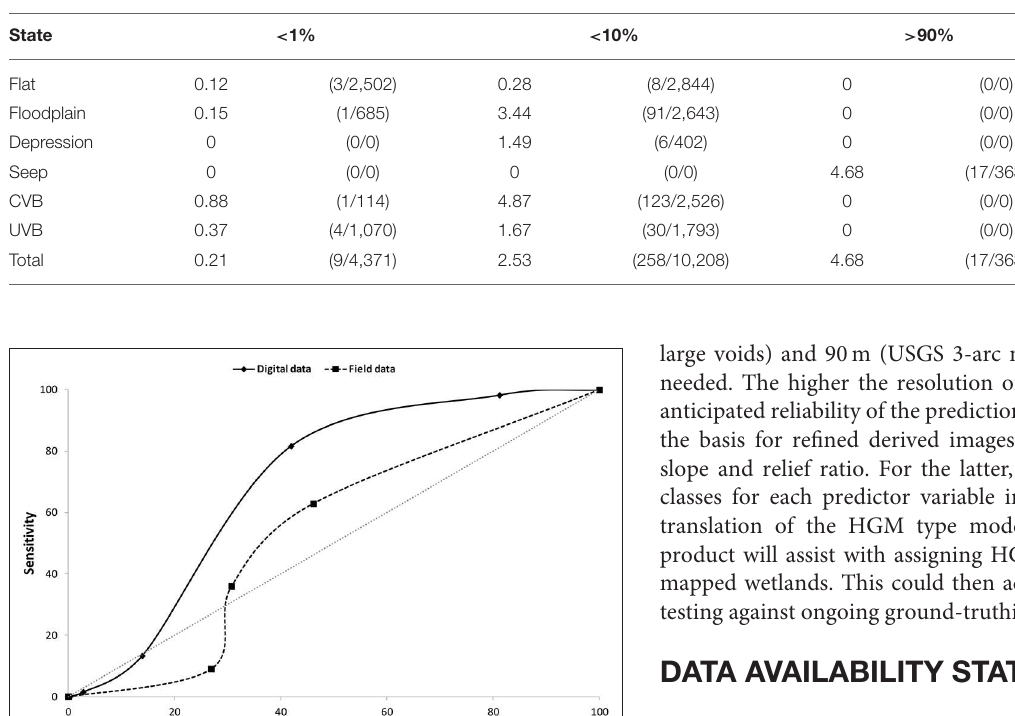
TABLE 6 | Number of times the Bn was “surprised” for different probability values.